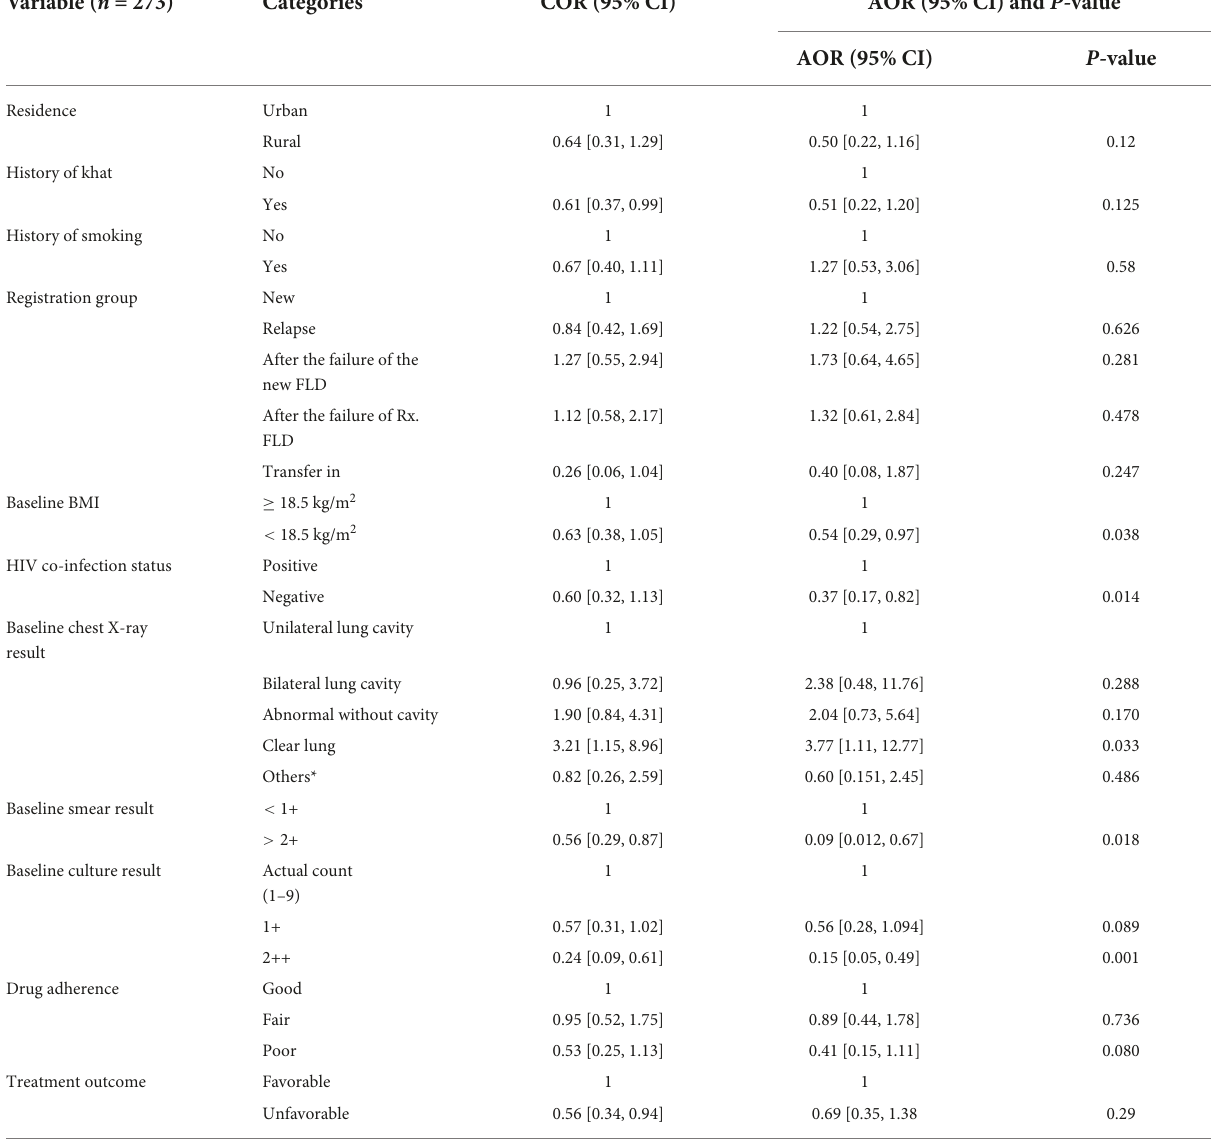
TABLE 4 Factors associated with first month sputum smear conversion among DR-TB patients in eastern, Ethiopia from 2013 to 2021 ( N = 273). Variable ( n = 273)